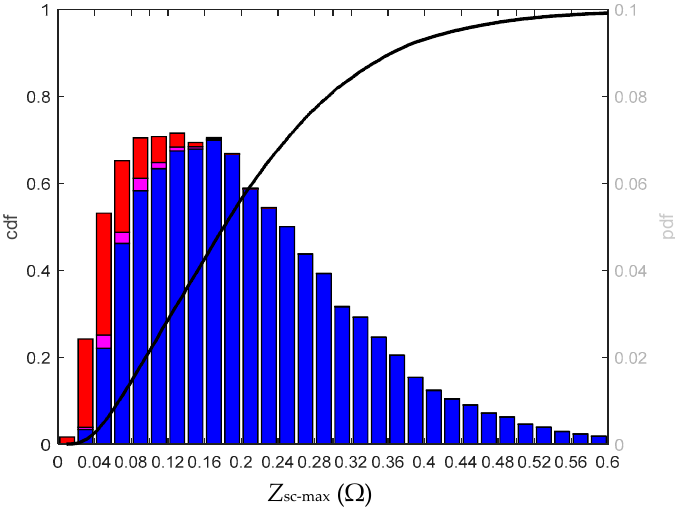
Figure 10. cdf of the short circuit impedance of the weakest node of feeders (red loading constrained, blue voltage constrained and purple loading and voltage constrained). Energies 2017 , 10 , 1099